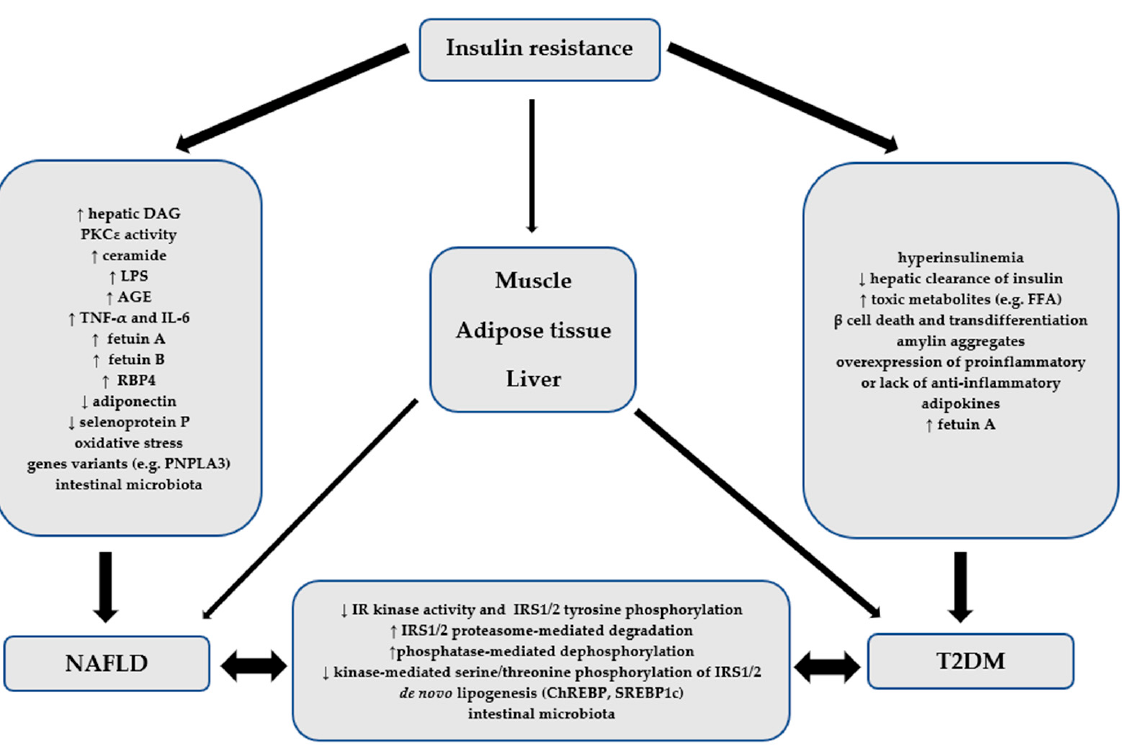
Figure 1. The pathophysiological relationship between NAFLD and T2DM. AGE—advanced glycation endpoint, ChREBP—carbohydrate response element-binding protein, DAG—